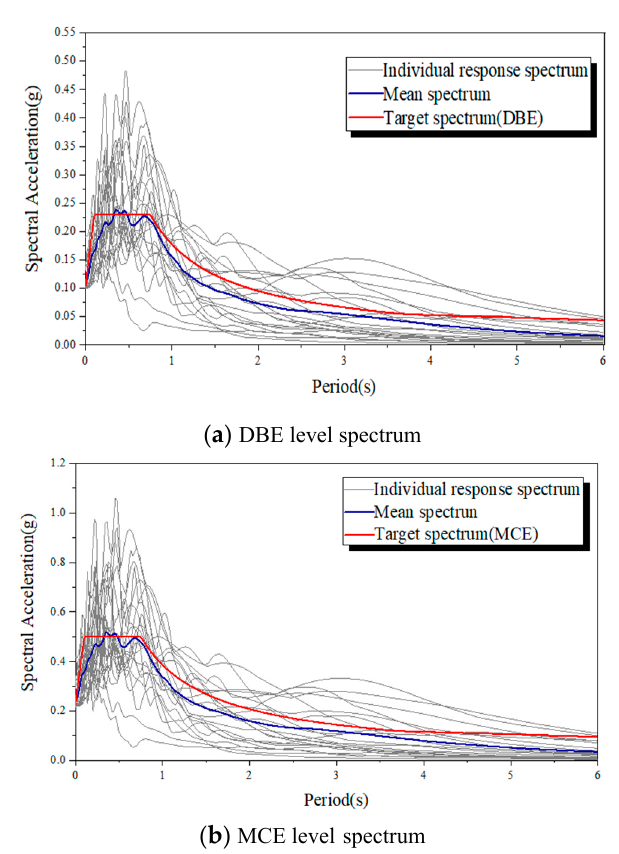
Figure 10. Acceleration response spectrum of near-fault earthquake waves.